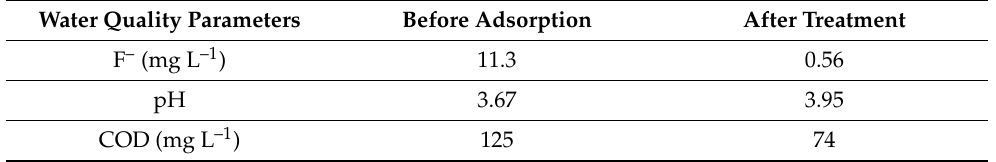
Table 5. Field trail results of